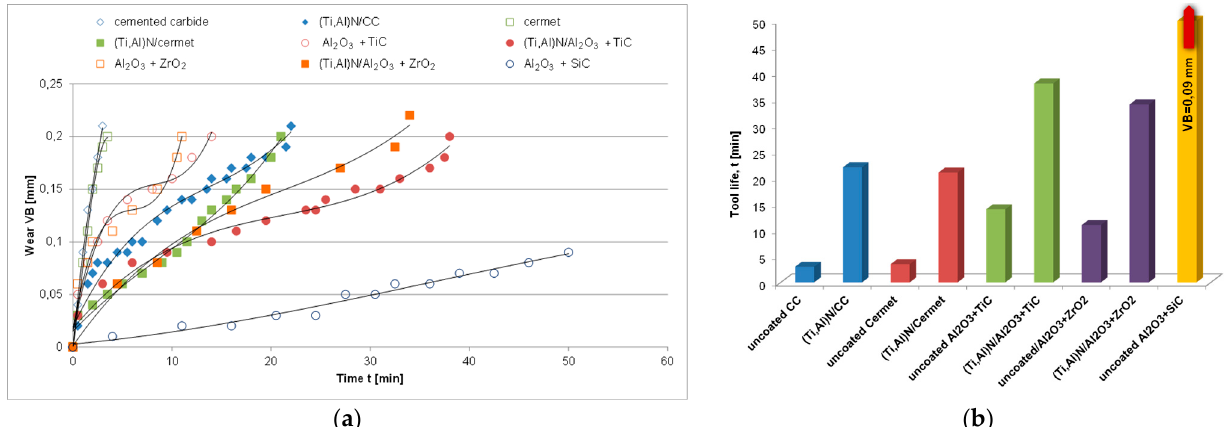
Figure 5. Comparison of the wear tracks ( a ) and tool life ( b ) of uncoated and coated sintered tool materials during cutting tests of EN-GJL-250 grey cast iron. VB criterion = 0.20 mm, feed rate, f = 0.1 mm/rev, depth of cut, a p = 1 mm, cutting speed, v c = 150 m/min.